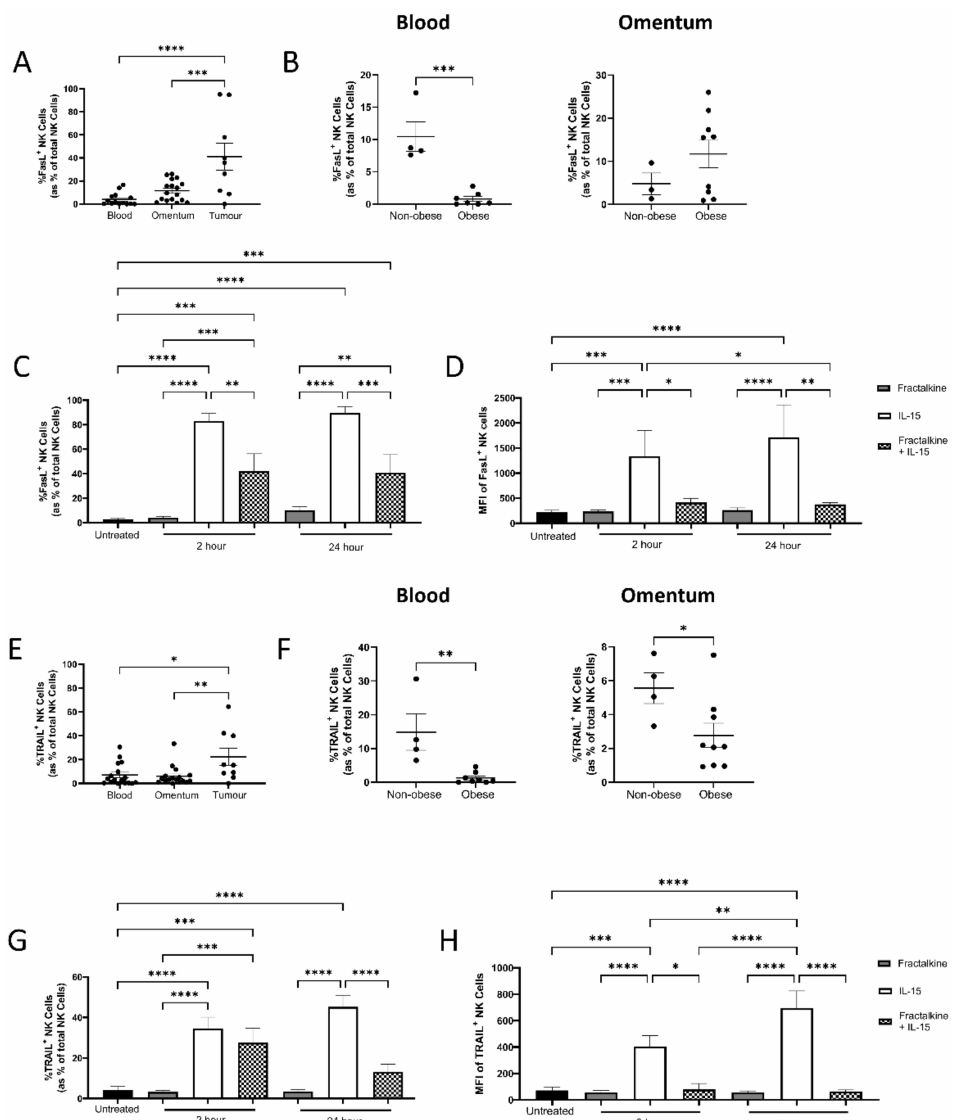
Figure 6. Death receptor ligand expressing NK cells are abundant in the OAC tumour and fractalkine antagonises the stimulatory effects of IL-15 on their expression. ( A ) Dot plot showing the frequencies of FasL + NK cells as a percentage of total NK cells in OAC patient derived blood ( n = 14), omentum ( n = 17) and tumour ( n = 8). ( B ) Dot plot showing the frequencies of FasL + NK cells as a percentage of total NK cells in OAC patient derived blood divided in to obese and non-obese by VFA in blood (left) and omentum (right). ( C ) Bar chart showing the frequencies of FasL + NK cells as a percentage of total NK cells following no treatment (untreated), treatment with 30 ng/mL fractalkine and/or 100 ng/mL IL-15 for 2 and 24 h. ( D ) Bar chart showing the MFI of FasL + expressing NK following no treatment (untreated), treatment with 30 ng/mL fractalkine and/or 100 ng/mL IL-15 for 2 and 24 h. ( E ) Dot plot showing the frequencies of TRAIL + NK cells as a percentage of total NK cells in OAC patient derived blood ( n = 20), omentum ( n = 17) and tumour ( n = 9). ( F ) Dot plot showing the frequencies of TRAIL + NK cells as a percentage of total NK cells in OAC patient derived blood divided in to obese and non-obese by VFA in blood (left) and omentum (right). ( G ) Bar chart showing the frequencies of TRAIL + NK cells as a percentage of total NK cells following no treatment (untreated), treatment with 30 ng/mL fractalkine and/or 100 ng/mL IL-15 for 2 and 24 h. ( H ) Bar chart showing the MFI of TRAIL expressing NK cells following no treatment (untreated), treatment with 30 ng/mL fractalkine and/or 100 ng/mL IL-15 for 2 and 24 h. One way ANOVA or t -test, * p < 0.05, ** p < 0.01, *** p < 0.001, **** p <